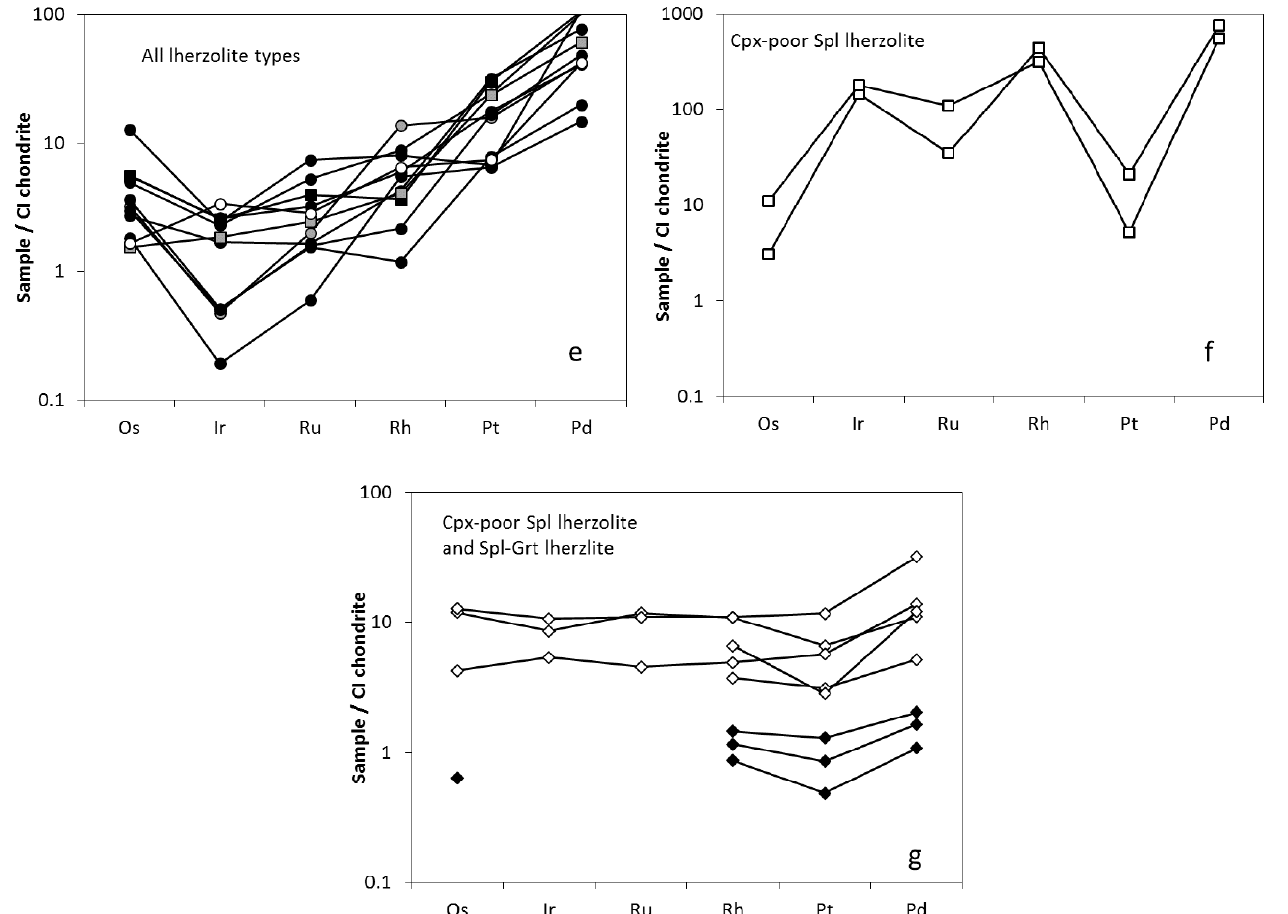
Figure 7. CI chondrite-normalized PGE patterns for the studied sulfides (CI chondrite composition is after Anders and Grevesse [41]). ( a ) Unmetasomatized residual sulfides of the e- and i-types from Cpx-rich Spl lherzolites and Spl-Grt lherzolites. Stepped distribution of the PGE is displayed by Pn (black circles), Ccp (grey circles), and Po (open circles) from a huge interstitial sulfide grain from Cpx-rich Spl lherzolite (see Figure 4d) and a huge sulfide grain included in Kel in Spl-Grt lherzolite (see Figure 5b). Almost unfractionated PGE distribution is observed for Ccp from an outer part of the inclusion in Spl (see Figure 4c), which is probably due to infiltration of immiscible sulfide melt from outside the Spl grain (cf. Figure 6c); ( b ) convex up PGE distributions in Pn and Ccp from sulfides of the e-type (in Spl and Ol) in Cpx-poor Spl lherzolite and in Cpx-rich Spl lherzolite (see Figures 3b and 4c); ( c ) almost unfractionated PGE patterns of Pn from sulfides of the i-type in Cpx-rich Spl lherzolite (see Figure 4e,f). These compositions could correspond closely to the initial stages of the mss break up; ( d ) insignificantly fractionated PGE patterns for Pn, Ccp, and Po from the e- and i-type sulfides in all three studied lherzolite types. The patterns are characterized by chondritic to suprachondritic PGE concentrations complicated by depletion in Pt and enrichment in Pd (see text for details); ( e ) strongly fractionated PGE patterns for Pn (low-Fe pentlandite is balck squares), Ccp, Po, and Pld (grey squares) from the i-type sulfides in all three studied lherzolite types. For most of these sample, an asymmetric “U”-shaped pattern due to fractionation of Ir relative to Os is typical; ( f ) convex up PGE patterns (complicated with a trough at Ru) from the Cu-Ni mss in Cpx-poor Spl lherzolite). Strong enrichment in Pd is observed (see text for details); ( g ) almost unfractionated PGE patterns (partly incomplete) for the m-type sulfides. PGE concentrations vary from chondritic (Py from silicate-carbonate patches; black diamonds) to around 10 × CI chondrite (Co-Vo from metasomatic veinlets; open diamonds).